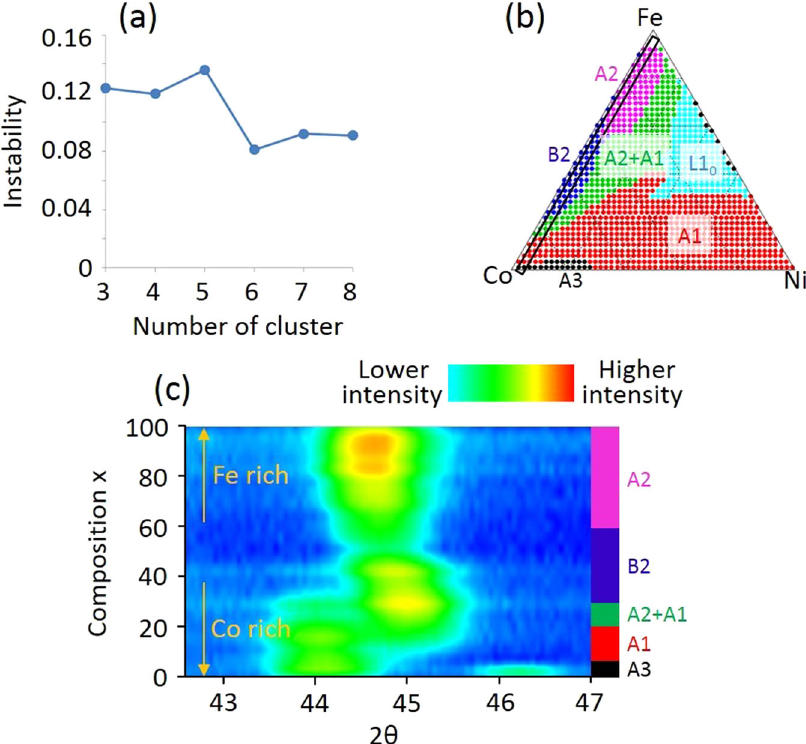
Fig. 6 Automated determination of the cluster number using the bootstrap method. a Result of cluster instability by the bootstrap method. b Result of cluster analysis with six clusters determined by bootstrap method. c Composition spread for XRD pattern in the black rectangle (Fe x Co 100-x Ni 2.5 ± 1.0 ) in Fig.